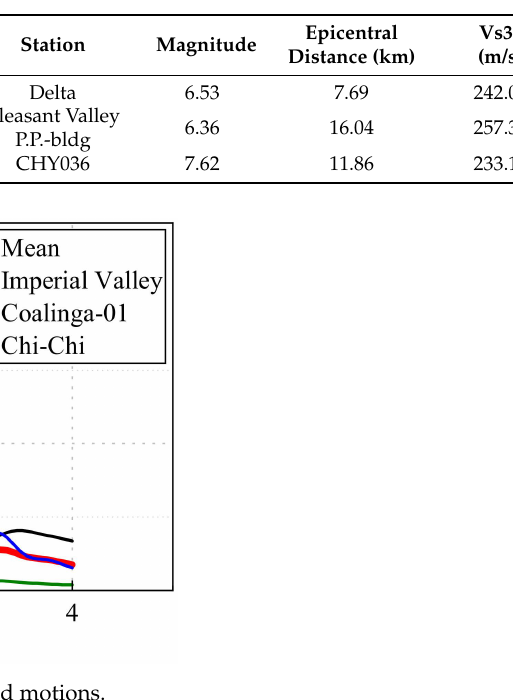
Table 3. Information of ground motions.